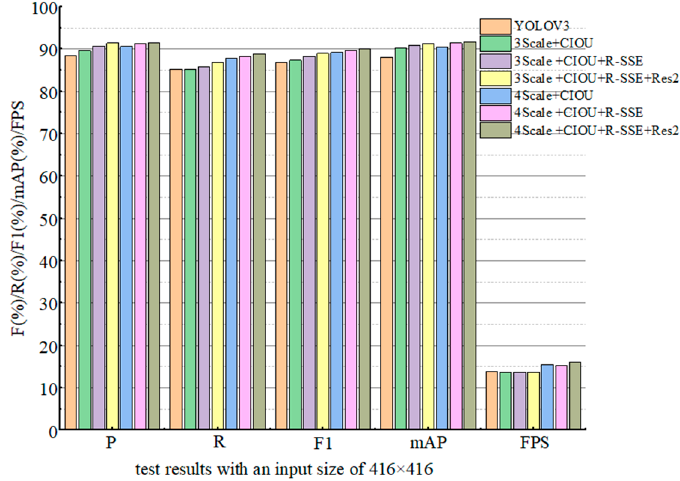
Figure 4. Histogram of test results with an input size of 416 × 416.